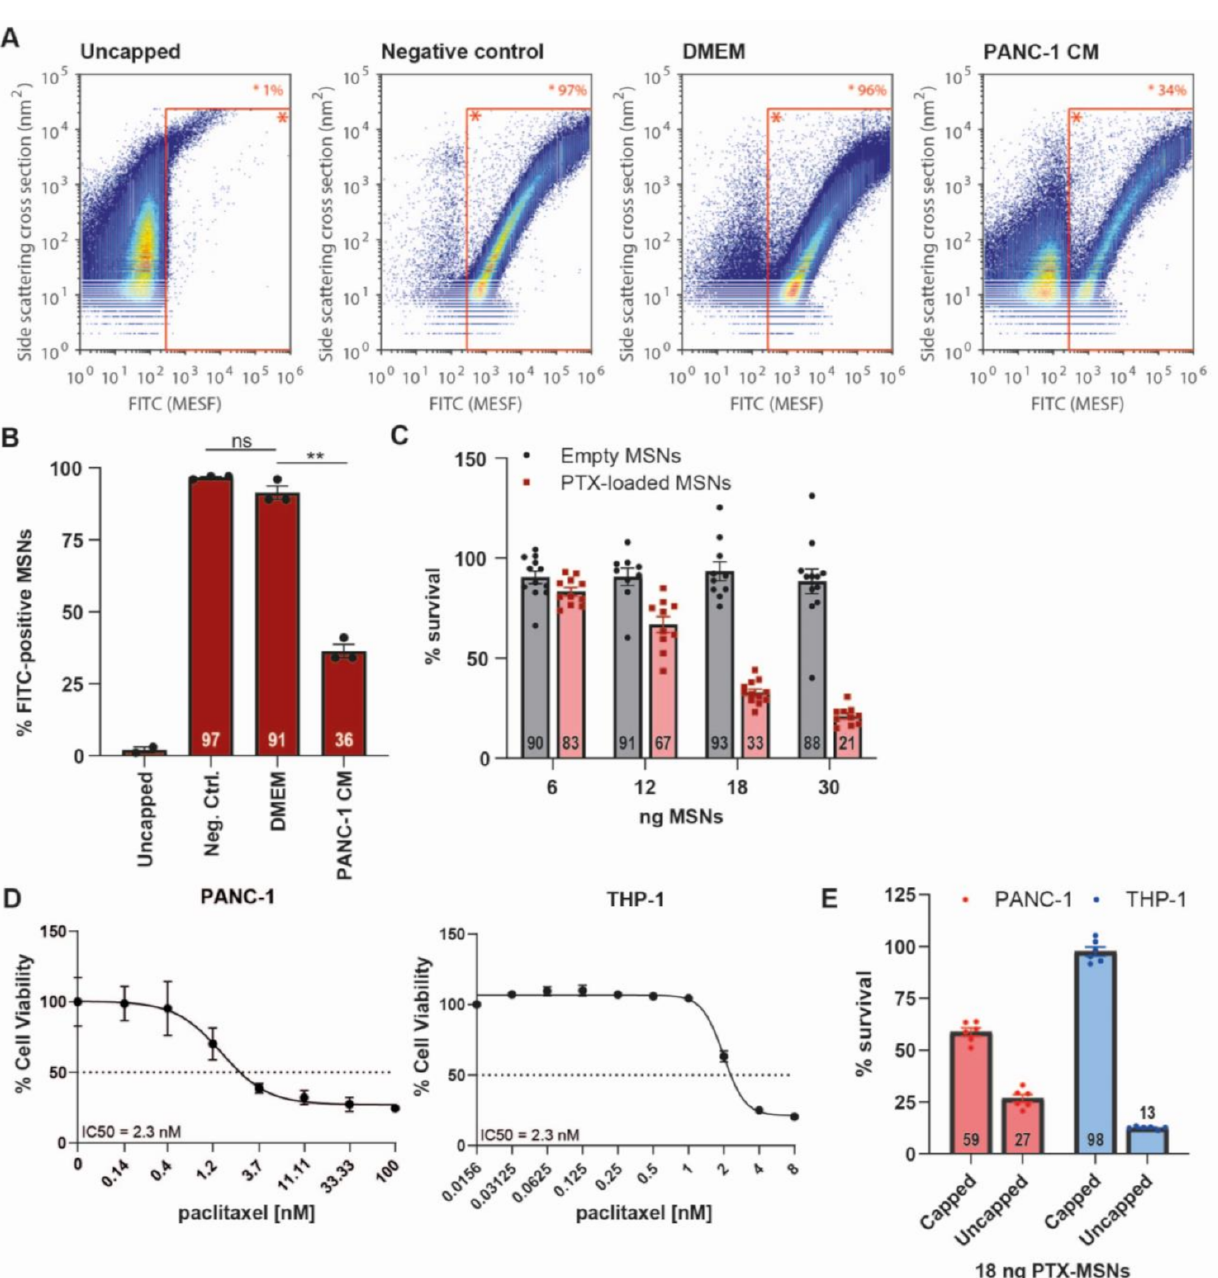
Figure 4. Removal of the avidin cap from MSNs is PDAC-specific and induces cell death. ( A ) Falcon Software-analyzed flow cytometry data showing the MSN distributions of representative samples ( n = 3) after capping with FITC-avidin and subsequent treatment with DMEM or PANC-1-derived conditioned medium; x -axis, FITC (MESH); y -axis, side scattering cross section (nm 2 ). ( B ) Visualization of percentage of MSNs that are FITC-positive, derived from population plots shown in Figure 4A ( n = 3, n = 2 for uncapped MSNs). ** = p < 0.01 as determined by the paired t -test. ( C ) Cytotoxicity of avidin-capped, empty and paclitaxel-loaded MSNs on PANC-1 cells after 72 h treatment in vitro. Data are shown as the mean of two experiments with n = 6. ( D ) IC50 curves of free paclitaxel on PANC-1 and THP-1 cells after 72 h treatment. ( E ) Cytotoxicity of capped and uncapped paclitaxel-loaded MSNs on PANC-1 and THP-1 cells after 72 h of treatment. Data are shown as the mean of one experiment with n = 6. All results are normalized to untreated